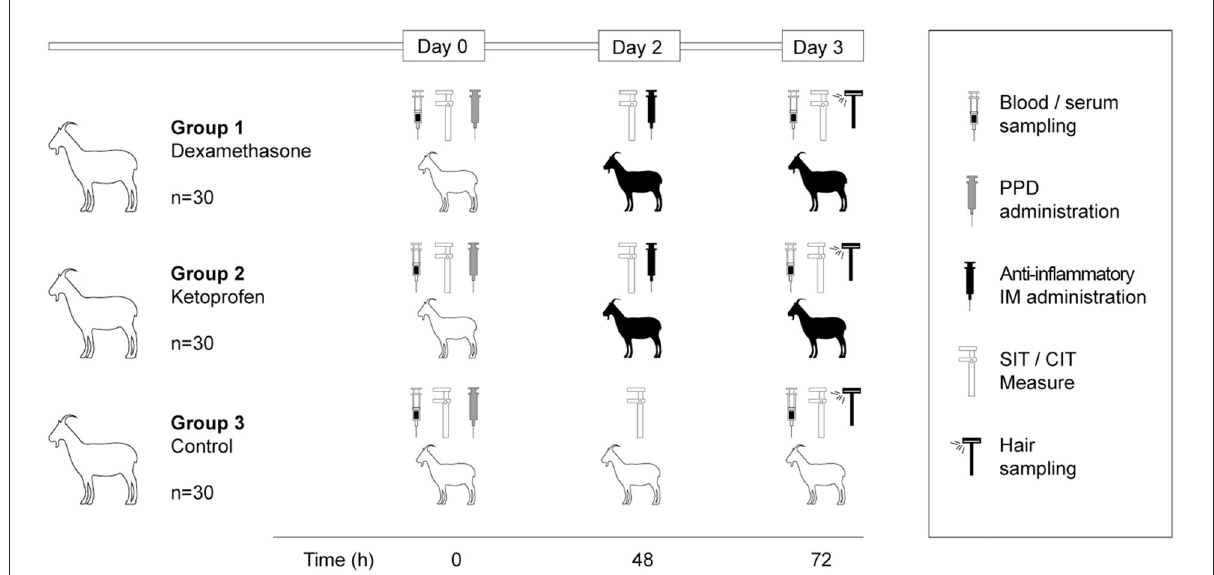
FIGURE1 Summary of the experimental design. White silhouettes represent goats untreated and black goat silhouettes represent goats treated with dexamethasone (0.06 mg/kg) or ketoprofen (3